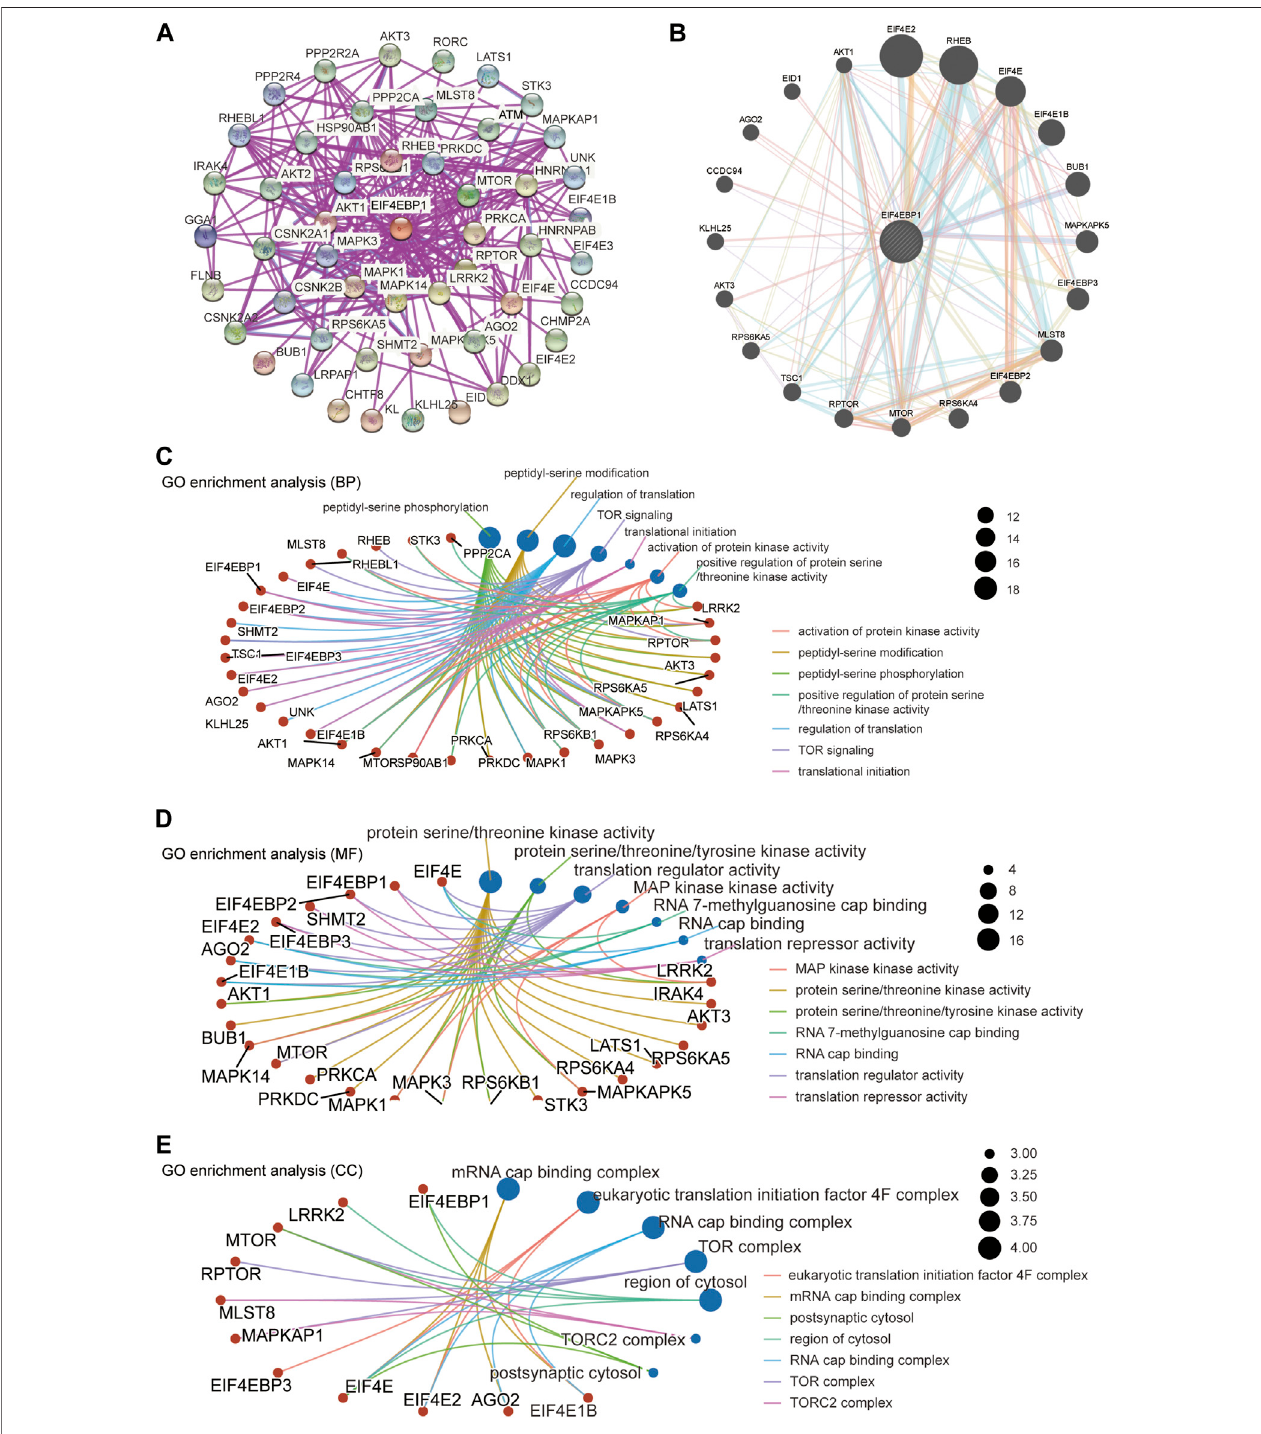
FIGURE 6 | 4EBP1-related gene enrichment analysis. (A) We obtained the available experimentally determined 4EBP1-binding proteins using the STRING database. (B) We used the GeneMANIA website to get the 20 genes most closely related to 4EBP1. (C) The biological process, (D) molecular function, and (E) cell components involved in 4EBP1 in GO enrichment analyses.